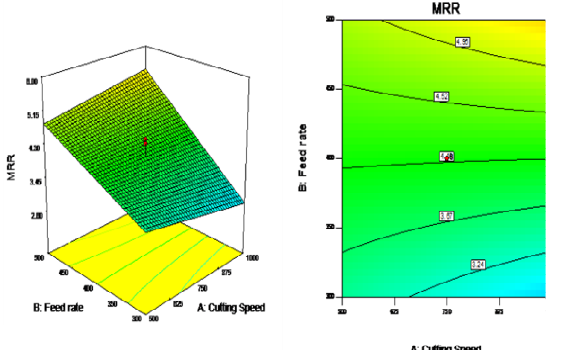
Fig. 9: 3D Response and Contour plot of Material Removal Rate Vs Cutting Speed and Feed Rate Fig. 10 depicts the 3D response and contour plot of MRR versus cutting speed and depth of cut. It is explored that at an initial value of the depth of cut with increasing cutting speed, MRR increases and at an initial value of cutting speed with the increase of depth of cut, MRR increases most significantly. It is also investigated that by increasing cutting speed and depth of cut, MRR will also be increased but the maximum value of MRR is achieved at a lower value of cutting speed and higher value of the depth of cut. The contour plot of MRR versus cutting speed and depth of cut shows that the maximum value of 5.14 cm 3 /min is achieved at the cutting speed of 693 RPM and depth of cut of 0.38 mm .